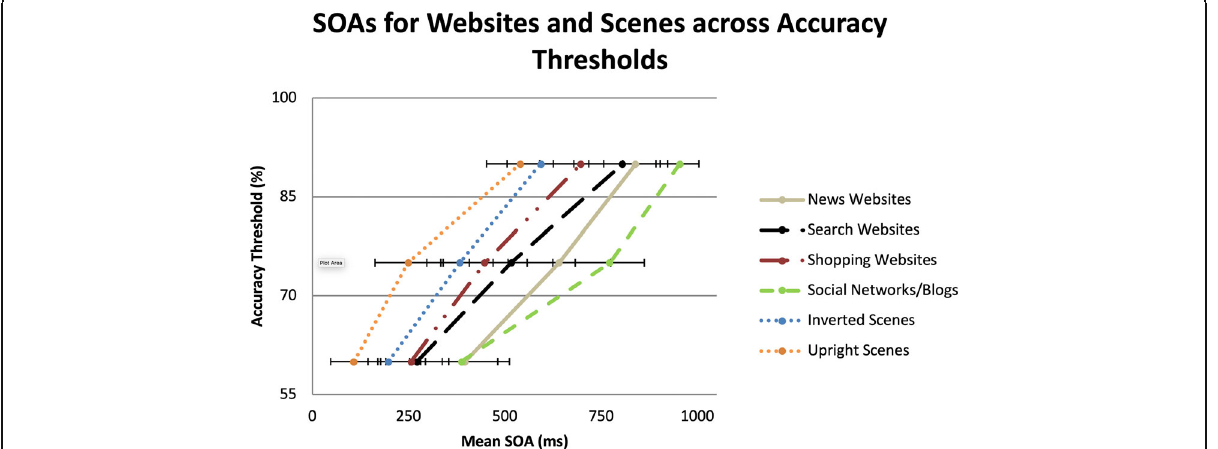
Fig. 4 Mean SOAs for websites and scene category accuracy thresholds. Maximum stimulus durations were limited to 140 ms, with blank ISIs making up the rest of the time for each SOA. Error bars are within-subjects 95% confidence intervals (Cousineau, 2005; Morey,